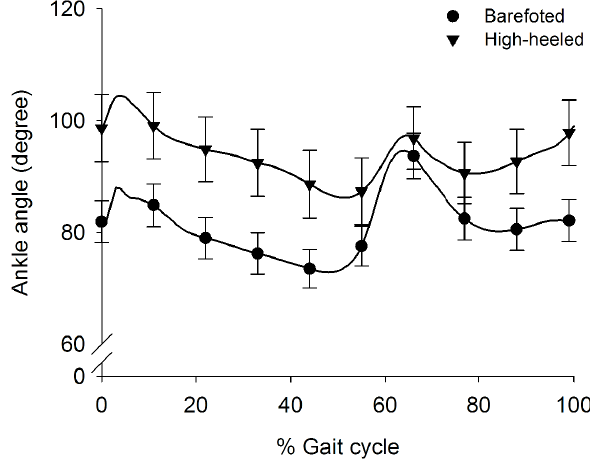
Figure 3. The ankle joint angle profiles. Ensemble average of the ankle joint angle (n=11) during barefooted (dots) and high-heeled (triangles) walking. The ankle joint angle of each subject is a mean 6 SE of the ankle joint angle from 50 strides measured over 60 s of walking and used as input to the ensemble averaging. Each ankle joint angle signal was time normalized prior to averaging. The x-axis is expressed as % stride time where 0% and 100% identify heel strikes of the same leg.